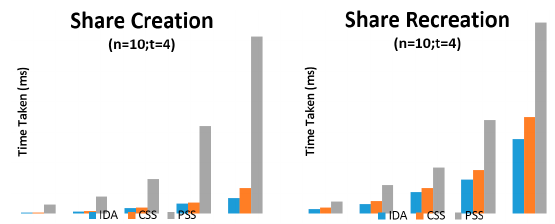
Figure 3. Share creation and recreation against increasing data sizes ( n = 5; t =2).